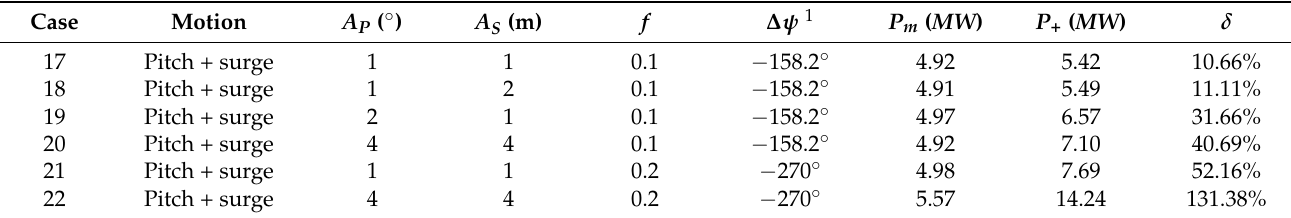
Table 9. Cases of combined motion with phase